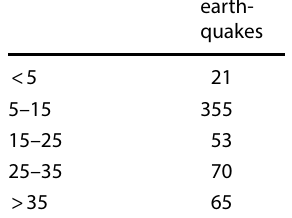
Table 4 Number of earthquakes with reference to depth